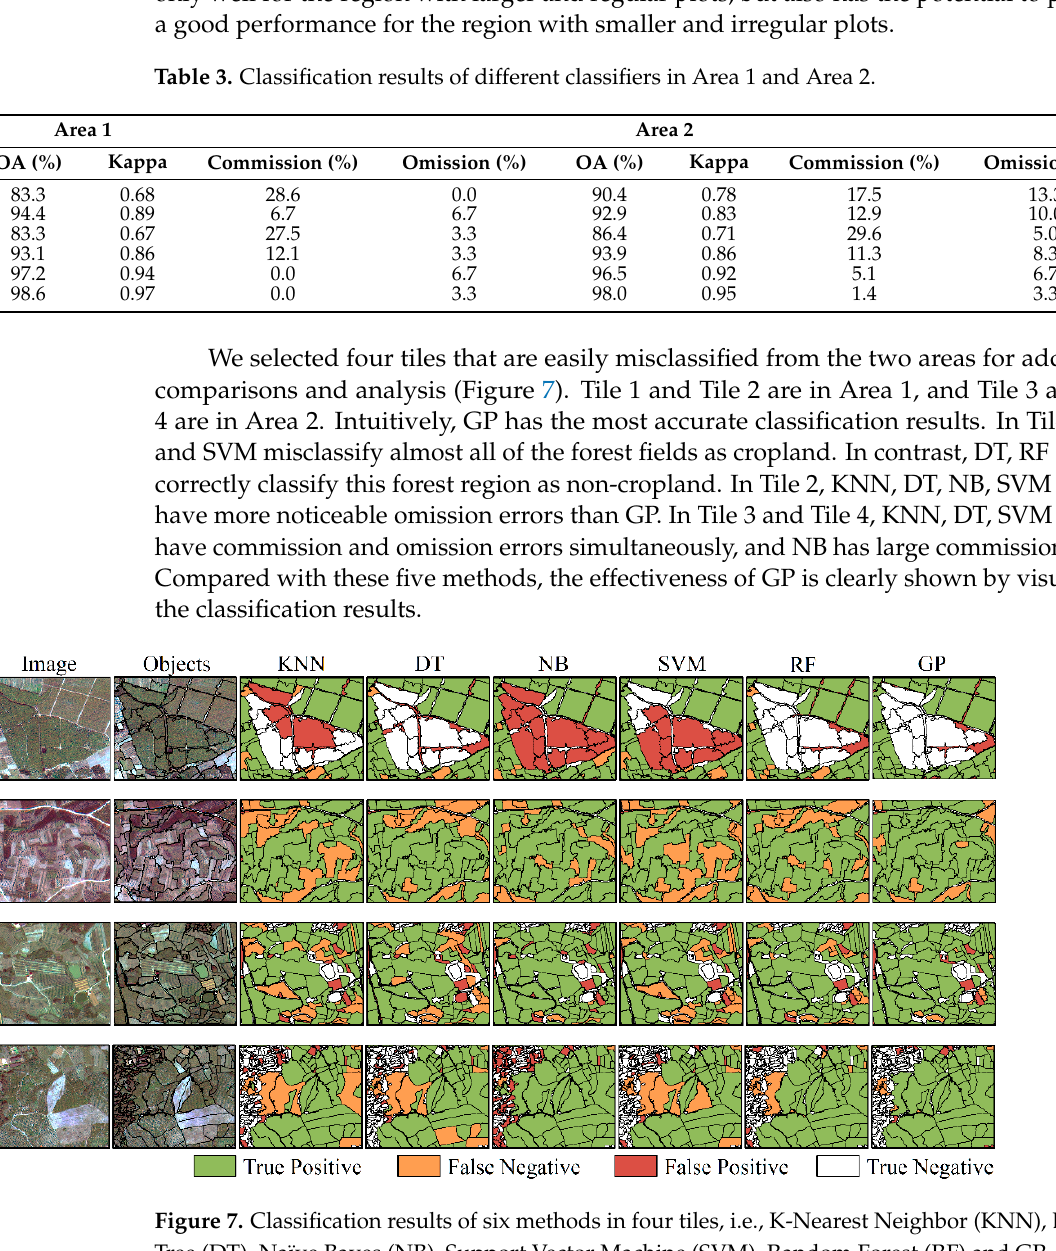
Figure 8. Effect of sample size on six classifiers in Area 1 ( a ) and Area 2 ( b ). 4.3. GP Classifier Analysis The optimal classifier was constructed by GP. The tree-based individuals consist of leaf nodes and internal nodes, and each individual represents a classifier. To better illus- trate the superiority of the classifiers generated by GP, the best individuals in the two